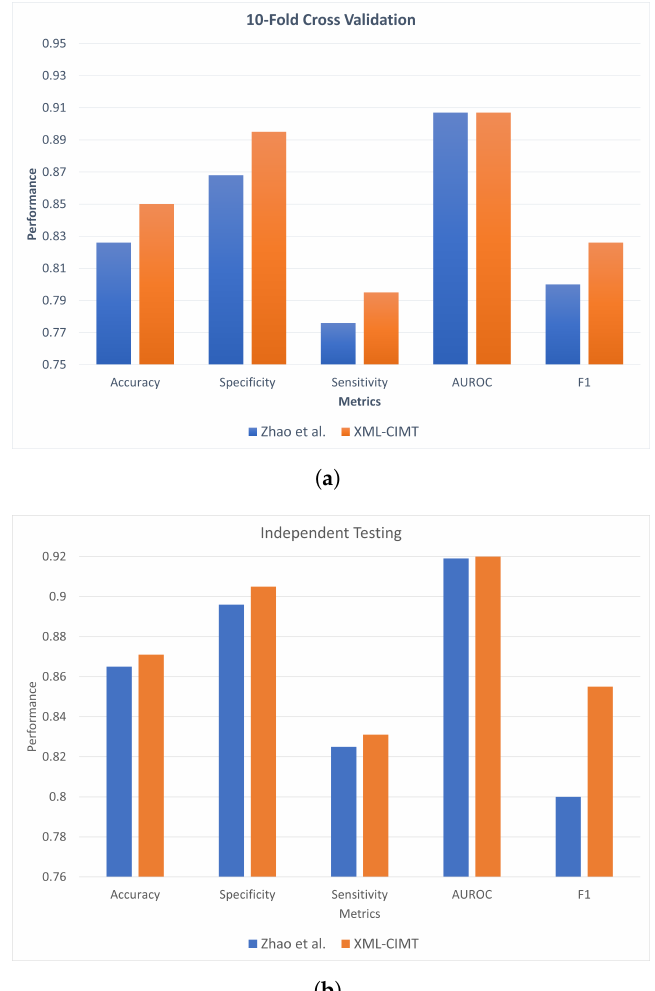
Figure 5. Performance comparison between XML-CIMT and Zhao et al. [17] model of results from ( a ) 10-fold cross validation and ( b ) independent